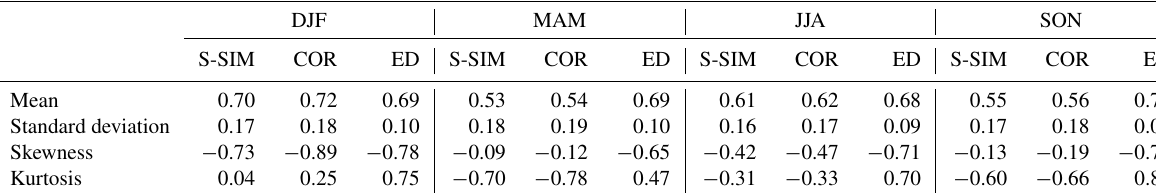
Table 1. Statistical indices of normalized discrimination distributions.